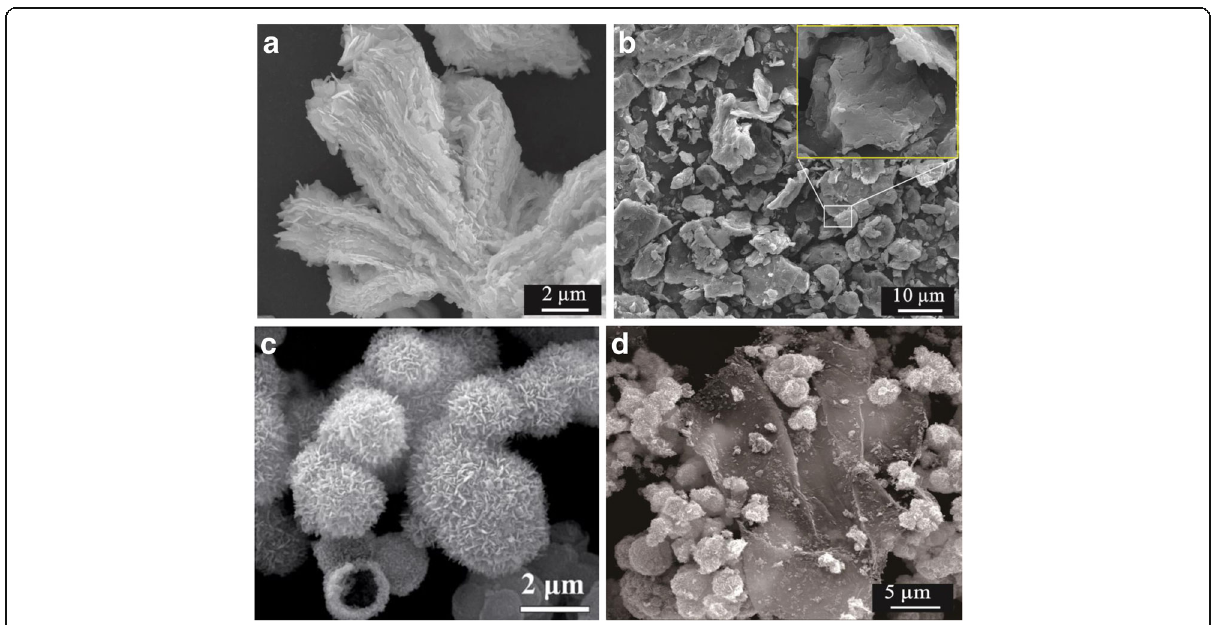
Fig. 2 SEM images of the bulk raw WS 2 ( a ), exfoliated WS 2 nanoslices ( b ), pure Bi 2 MoO 6 ( c ), and WS 2 /Bi 2 MoO 6 (5 wt%) composite ( d )